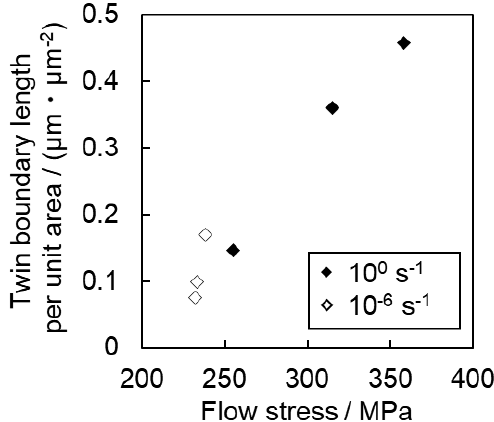
Figure 14. Relationship between twin boundary length per unit area and flow stress in Ti-30.